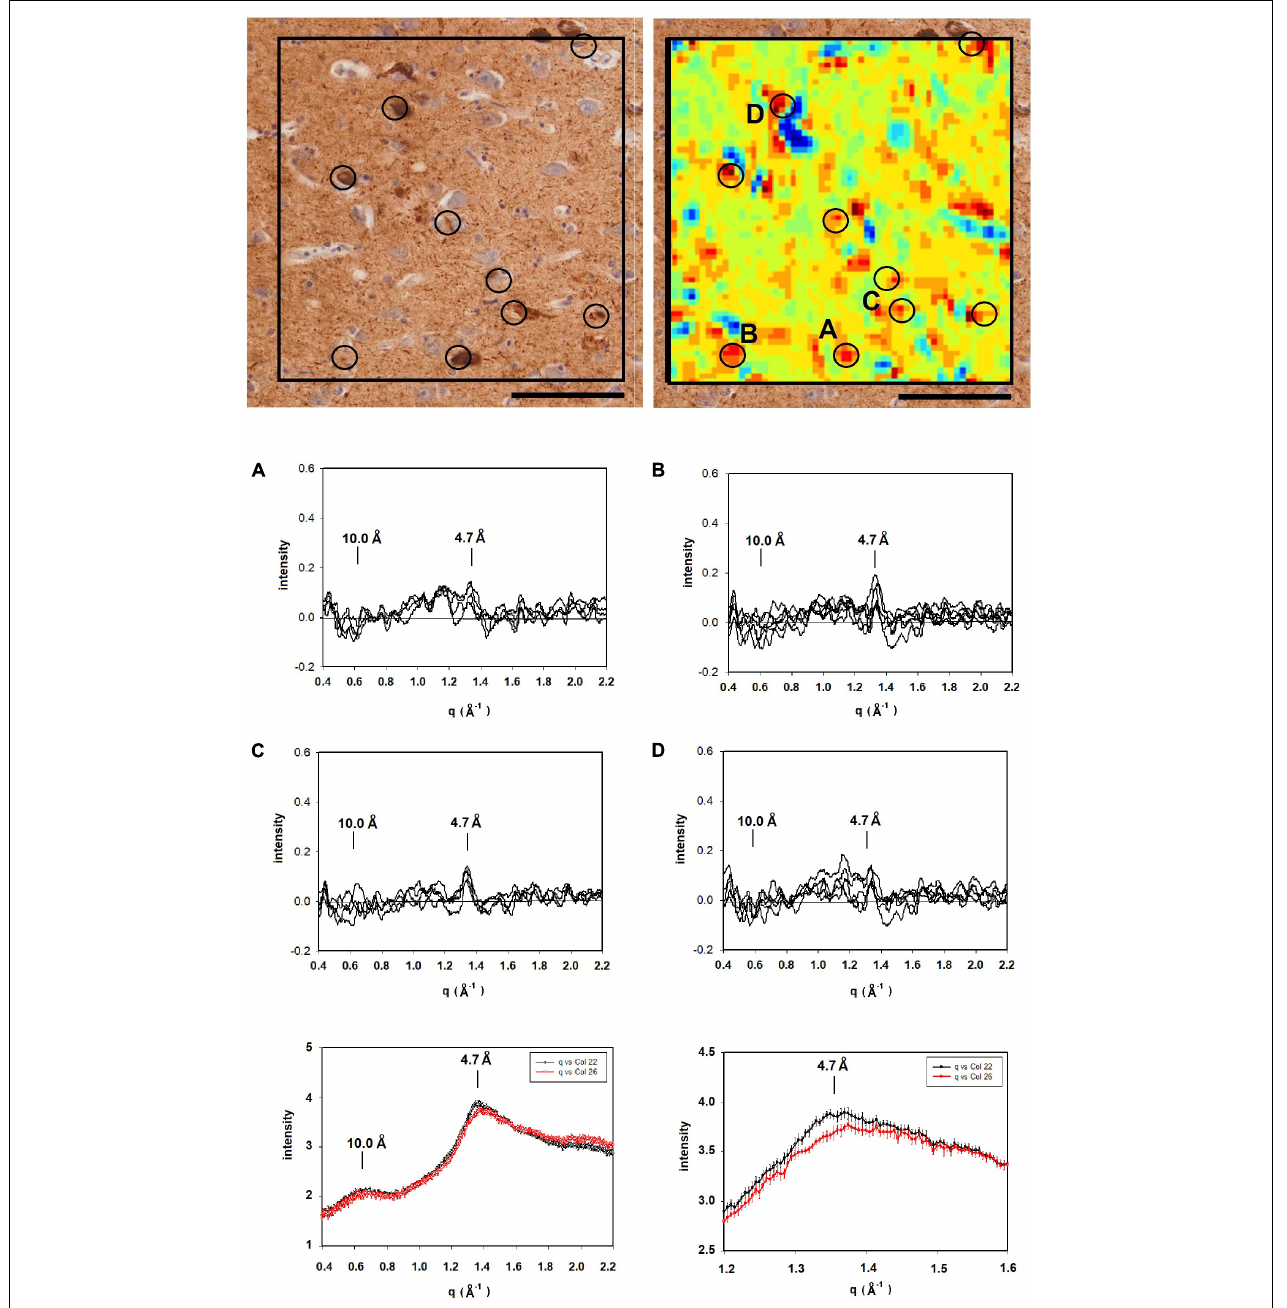
FIGURE 5 | (Left) Serial section of entorhinal cortex of a Down Syndrome case with a secondary diagnosis of Alzheimer’s disease (ADNC) stained for tau (left) compared to a map of the intensity of 4.7 Å scattering from an adjacent unstained section (right). Immunohistochemistry indicated that A β was absent from these sections. (A–D) Scattering in the wide-angle region from lesions (A–D) in the corresponding x-ray scattering map (top right) indicated that the scattering was most intense at 4.7 Å, indicating high concentration of cross- β structures. (bottom) Plots of the average and standard deviations of lesions (black) and tissue (red) in the section shown at the top. Greatest difference between lesion and tissue is in the regions around 4.7 Å spacing. Scale bar 100 µ .